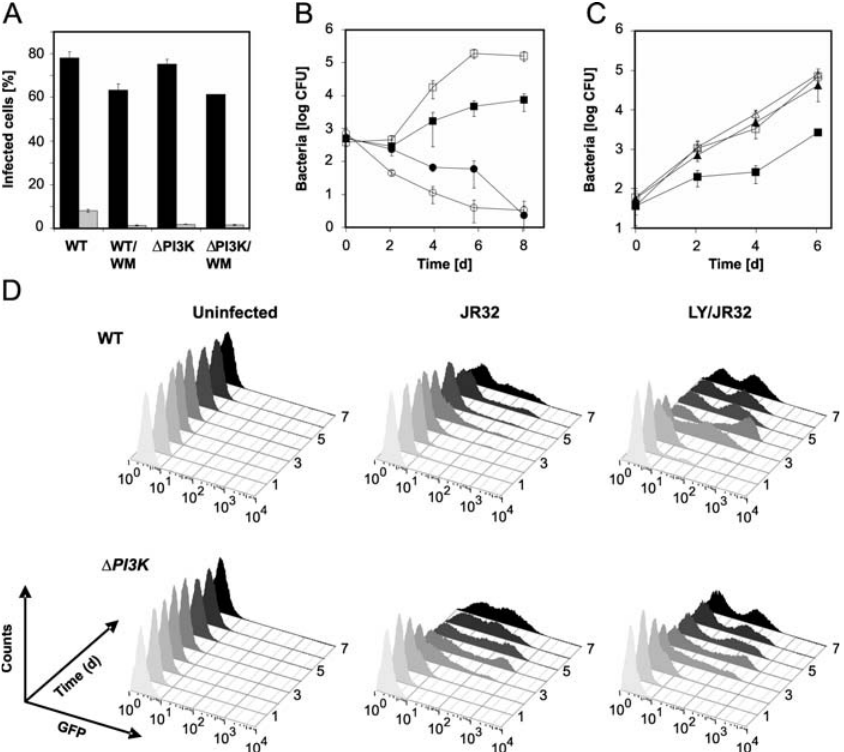
Figure 2. A Role for PI3Ks in Intracellular Replication but Not Phagocytosis of Wild-Type L. pneumophila (A) Phagocytosis by Dictyostelium wild-type Ax3 or D PI3K1/2 (untreated or treated with 5 l M WM) of GFP-labeled L. pneumophila wild-type (black bars) or a D icmT mutant strain (grey bars) was determined by flow cytometry. (B) Release of L. pneumophila wild-type (squares) or D icmT (circles) into the supernatant of Dictyostelium wild-type (denoted by filled symbols) or D PI3K1/2 (denoted by open symbols) was quantified by CFUs. (C) Release of wild-type L. pneumophila (CFUs) from Dictyostelium wild-type (filled squares denote untreated; filled triangles denote 10 l M LY) or D PI3K1/2 (open squares denote untreated; open triangles denote LY). (D) Quantification by flow cytometry of intracellular growth of GFP-labeled wild-type L. pneumophila within wild-type Dictyostelium or D PI3K1/2 in the presence or absence of 20 l M LY. The data shown are means and standard deviations of duplicates (A) or triplicates (B and C), and are representative of at least three independent experiments